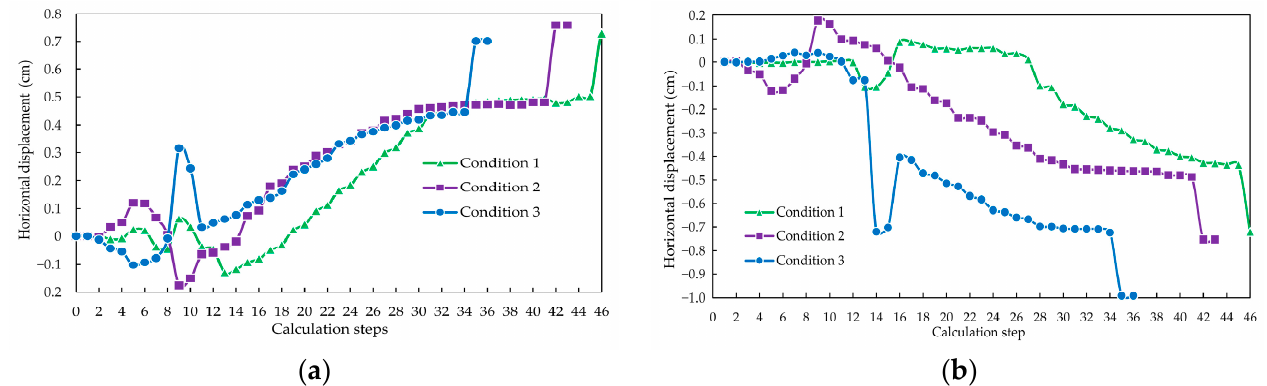
Figure 10. The curve of horizontal displacement of the arch waist with construction steps: ( a ) Measuring point 1; ( b ) Measuring point 2.